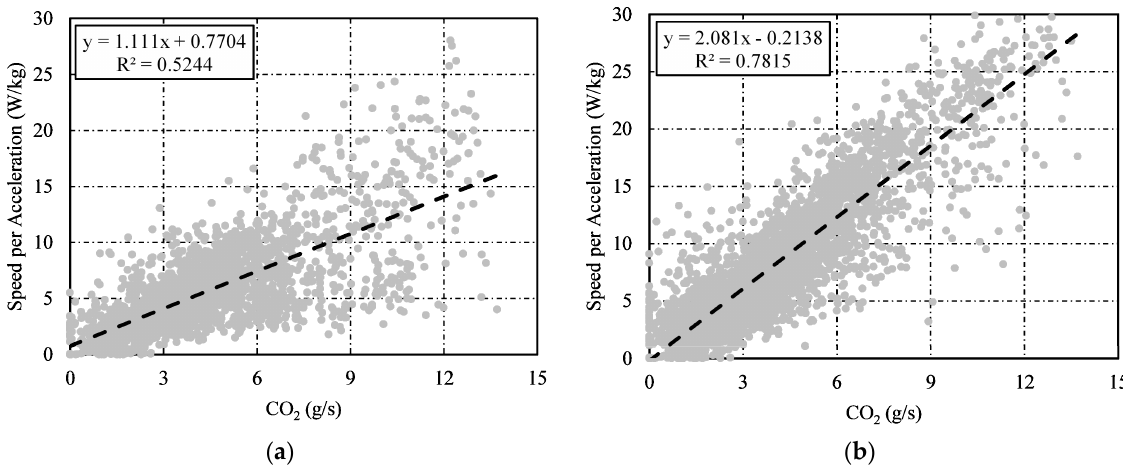
Figure 8. Correlation between CO 2 and speed per acceleration. ( a ) Correlation between CO 2 and v·a pos . ( b ) Correlation between CO 2 and v·a eng .